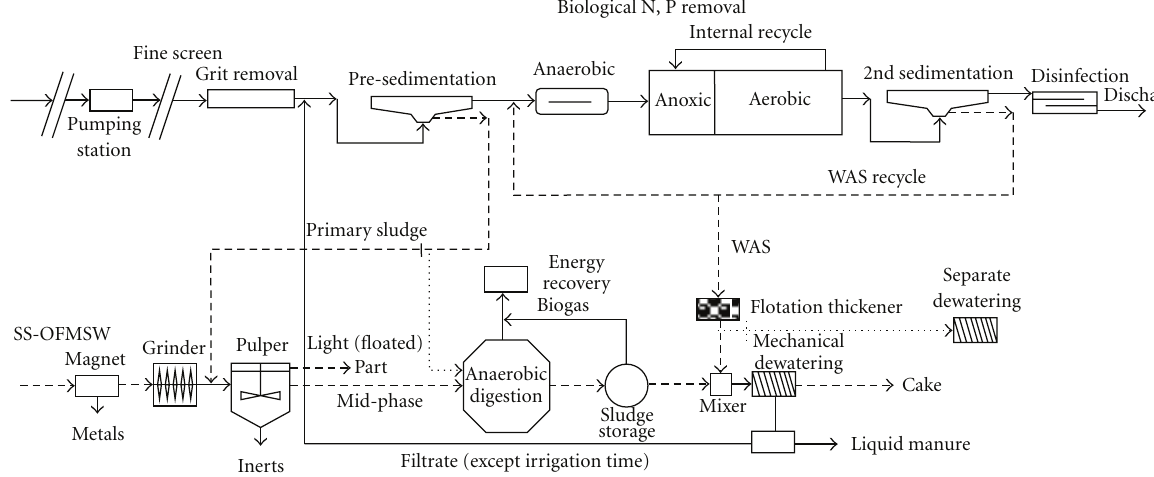
Figure 1: Process scheme of the municipal WWTP and the integrated biomethanization